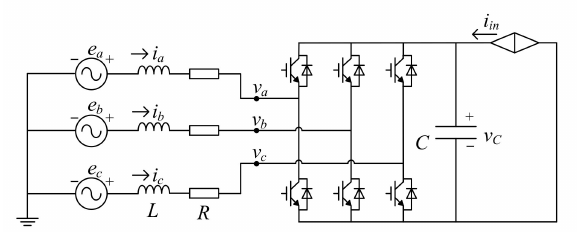
Figure 1. Topology of a Typical Three-Phase